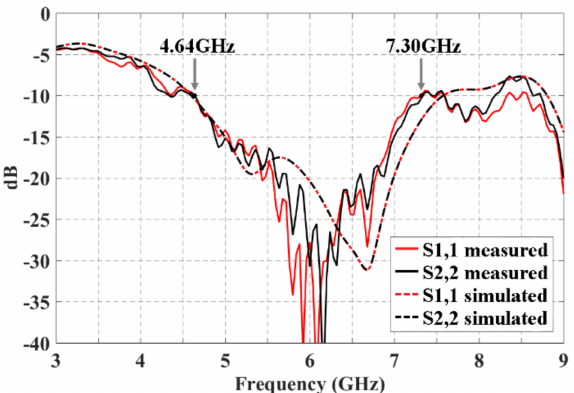
Figure 5. Reflection coefficients obtained by full-wave simulation and measured experimentally for the block of 2 × 3 CORPS